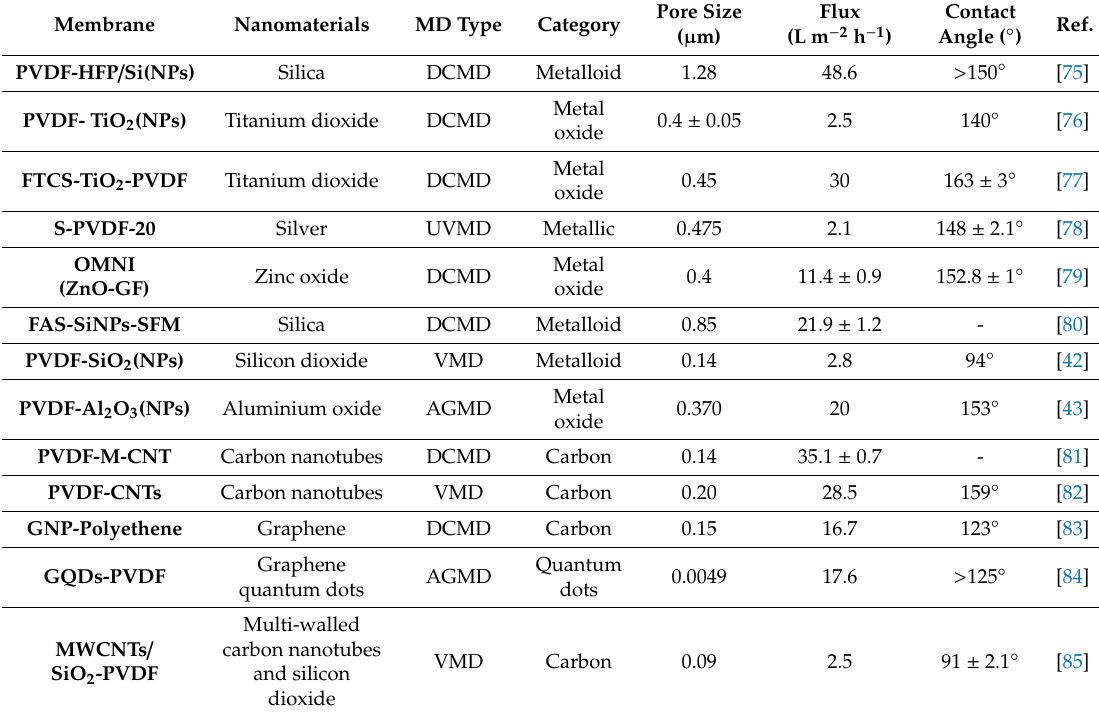
Table 2. State-of-the-art of nanomaterial-based MD membranes for improved desalination performance.